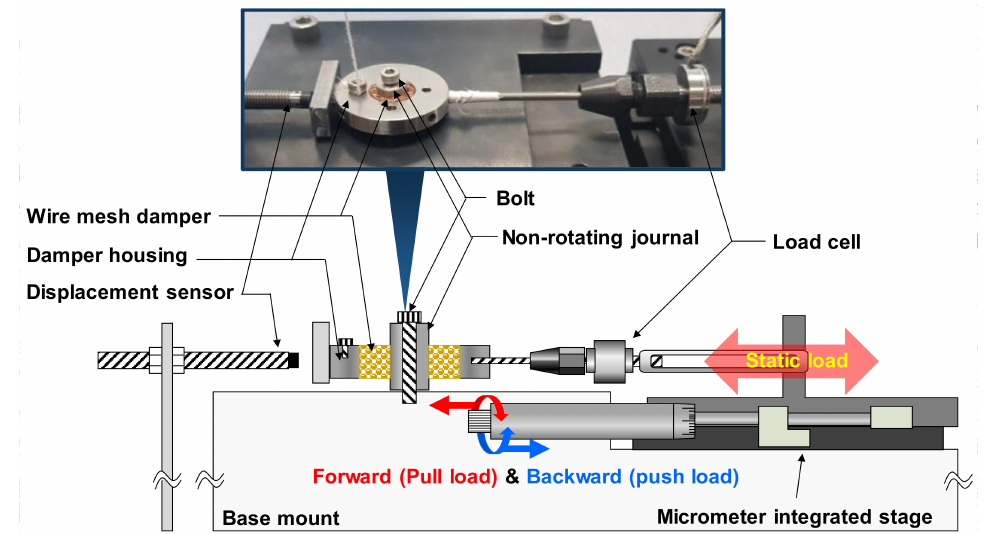
Figure 3. Schematic view (not to scale) and photograph of experimental setup for WMD structural deflection test with static push-pull loads.